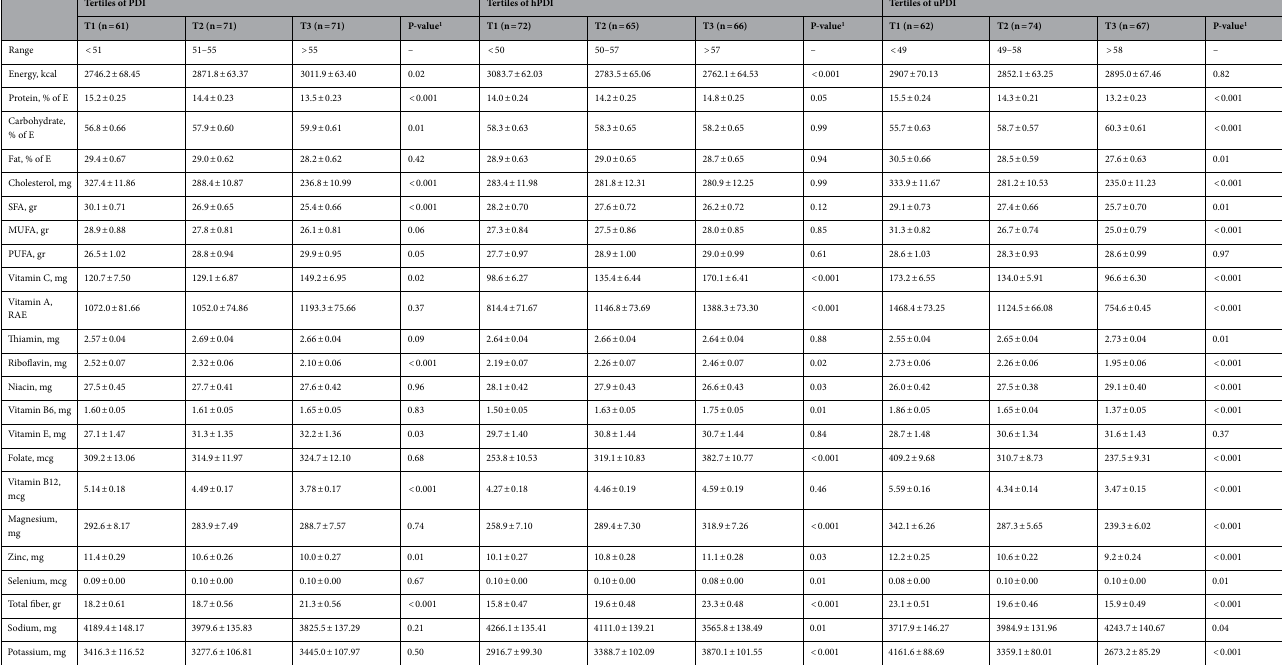
Table 2. Dietary intakes (energy and macro/micro nutrients) of study participants across tertiles of PDI, hPDI and uPDI. Values are Mean ± SE. Energy intake was adjusted for age and gender; all other values were adjusted for age, gender and energy intake (by the use of ANCOVA). Abbreviations: E: energy intake; SFA, Saturated fatty acids; MUFA, Monounsaturated fatty acids; PUFA, Polyunsaturated fatty acids. 1 P-value obtained from ANCOVA test for adjustment of energy intake.